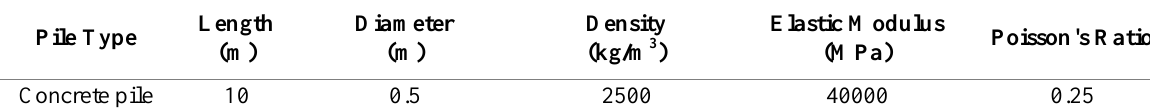
Table 2. Pile properties used by Masoumi et al.